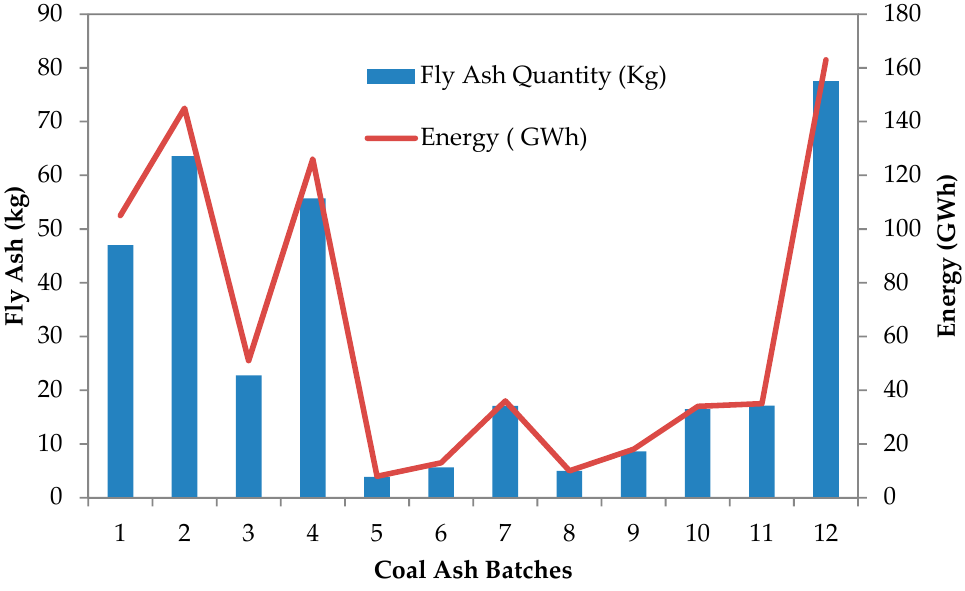
Figure 21. Fly ash data and energy production of a power plant from northern peninsular Malaysia.